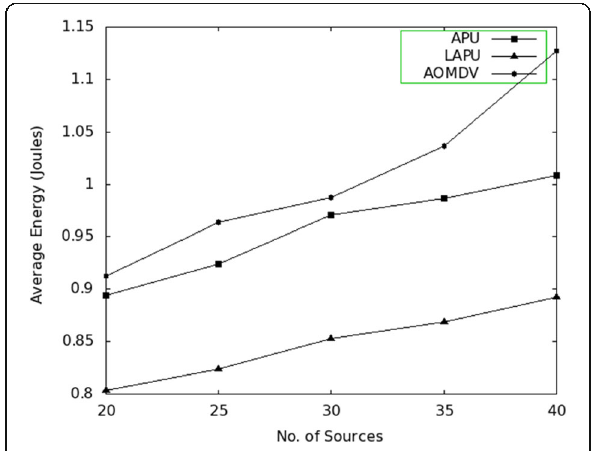
Fig. 12 Average energy consumption vs. number of